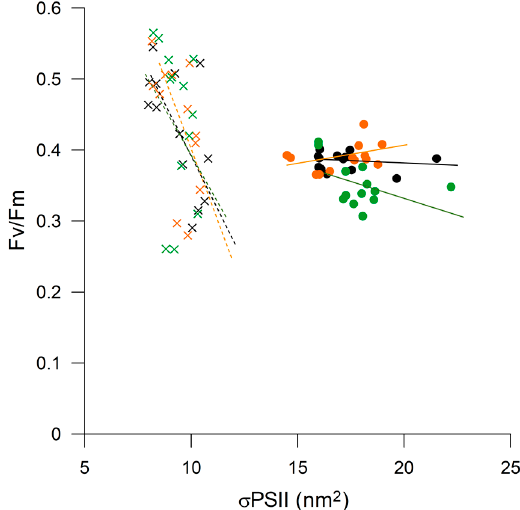
Figure 9. Fv / Fm plotted against relative functional absorption cross-section of PSII ( σ PSII) for Prorocentrum sp. (symbol X) and Phaeocystis antarctica (symbol • ) with color indicating di ff erent treatments. CTRL (black), -B12 (orange), DFB (green). The figure includes all data points with trend lines.